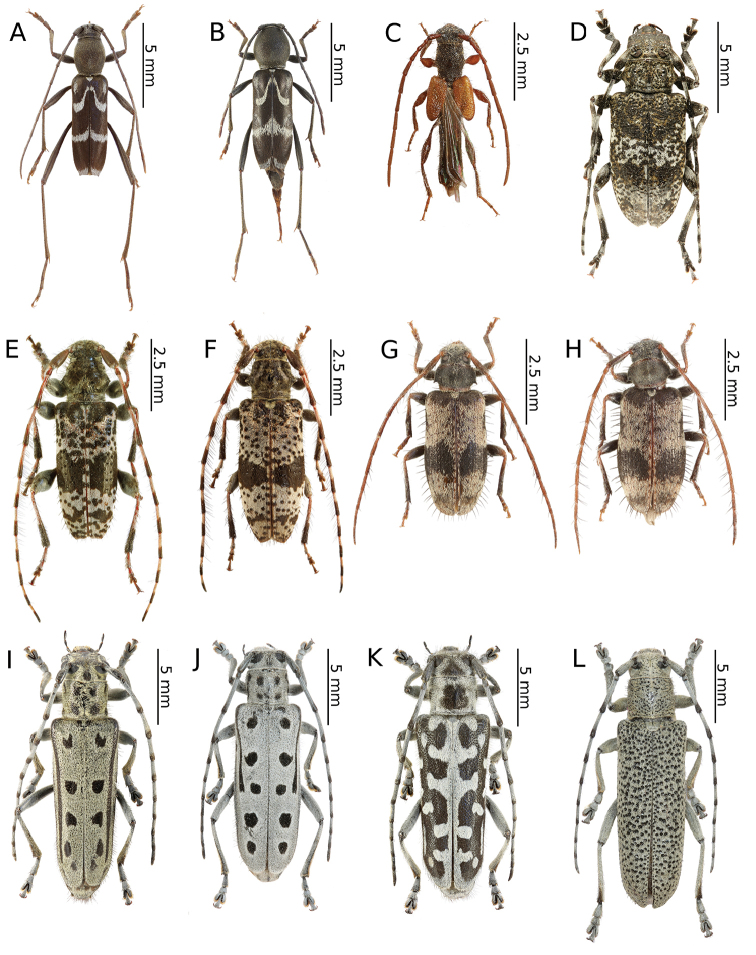
Photos of longhorn beetles specimens collected during the expedition to Kazakhstan in 2017: ARhaphumagracilipes (male) BR.gracilipes (female) CMolorchusschmidti (female) DAegomorphusobscurior (female) ERopaloscelisunifasciatus (male) FR.unifasciatus (female) GExocentrusstierlini (male) HE.stierlini (female) ISaperdaalberti (female, whitish form) JSaperdaperforata (female, whitish form) KSaperdascalaris (female, whitish form) LSaperdasimilis (female, whitish form).